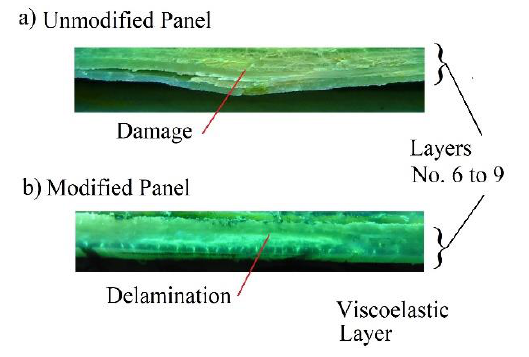
Figure 28. Comparison of the impact section for weight drop at 80 J characterized with fluorescent penetrating inks for unmodified panels ( a ) and modified panels ( b ).